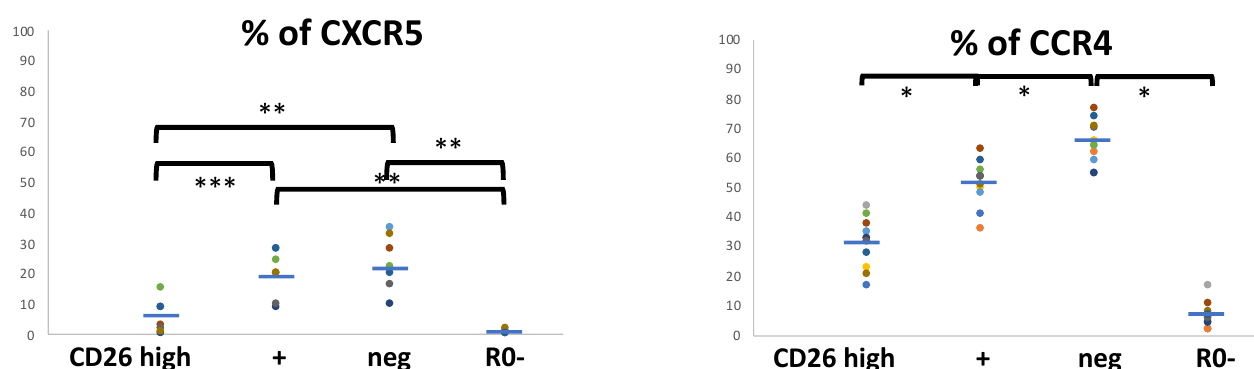
Figure 3. Markers of pre-effector programs in CD4 T cell subsets defined with CD26 and CD45R0. Cell-surface CXCR5 and CCR4 positivity frequencies in the four CD4 + T cell subsets defined by surface CD45R0 and CD26 expression. Lymphocytes were gated using the same strategy shown in Figure 1, and for each marker of T EM and T CM subsets, its panel shows the respective frequencies in the respective gated region (the three CD45R0 with CD26high, + or neg, and the R0-, CXCR5: 5.6 ± 5.5, 19.9 ± 7.8, 23.4 ± 9.1, 0.6 ± .8, n = 7; CCR4: 31.4 ± 8.4, 51.5 ± 7.7, 65.2 ± 7.3, 6.6 ± 4.3, n = 11). * p < 0.001, ** p < 0.01, *** p < 0.05.